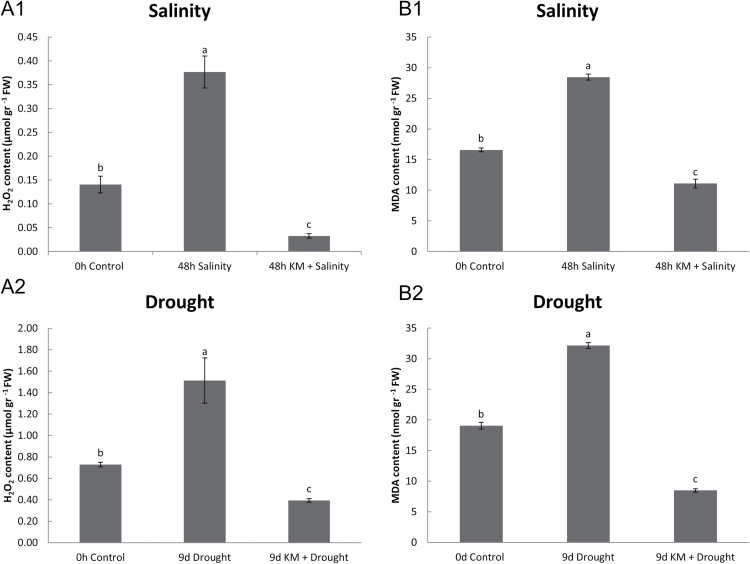
(A) Hydrogen peroxide content and (B) cellular damage (indicated by leaf MDA content) in salinity-stressed (A1, B1) and drought-stressed (A2, B2) M. truncatula plants in the absence or presence of KM pre-treatment (KM 10–8 M).